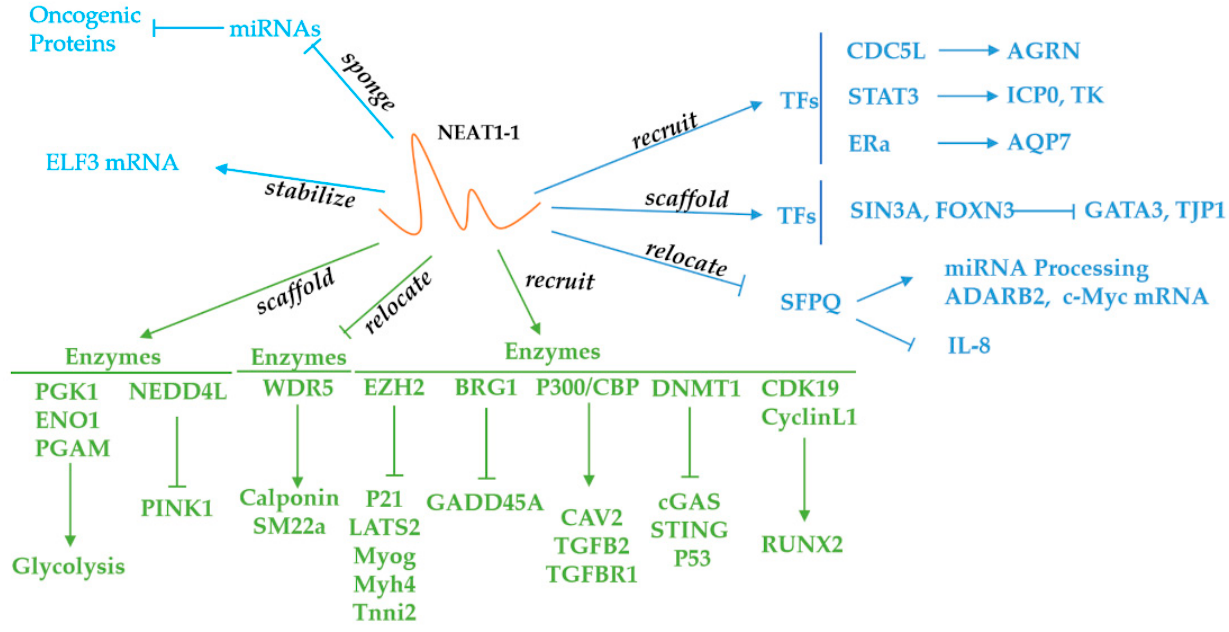
Figure 2. Function and Signaling Pathways of NEAT1. NEAT1 can recruit enzymes and TFs to the genome locus. NEAT1 can also sponge miRs and relocate enzymes and SFPQ to suppress the function of these molecules. In addition, NEAT1 can form a scaffold bridge between different TFs, which allows the enzymes to bind more tightly to the substrates.